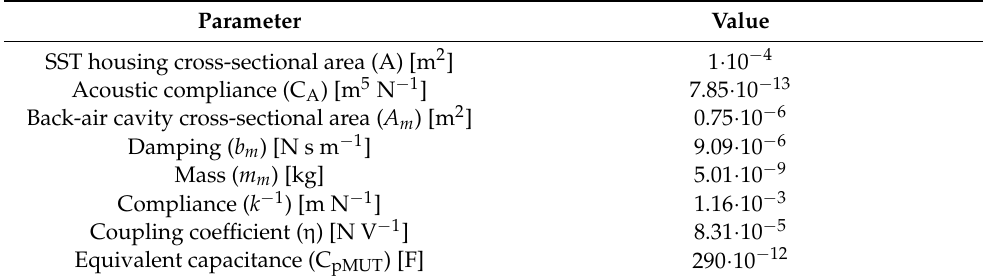
Table 5. Values of the lumped parameters for the coupling cavity and the pMUT.